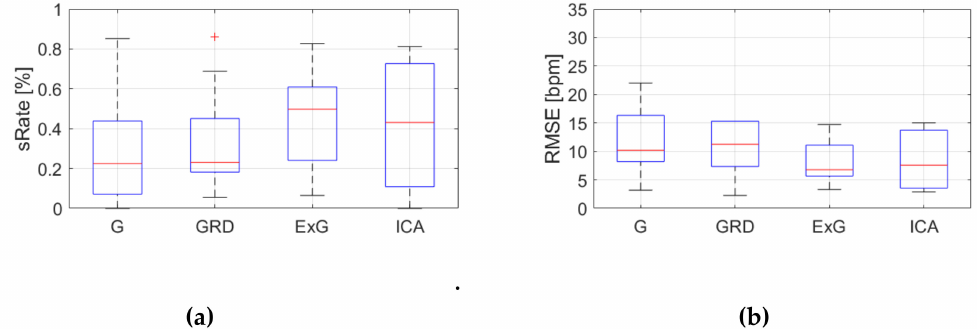
Figure 11. Comparison of signal extraction methods, algorithm No.1 (PSD), part 4: ( a ) box plots for sRate ; ( b ) box plots for RMSE . Blue lines—IQR range, red line—median value.